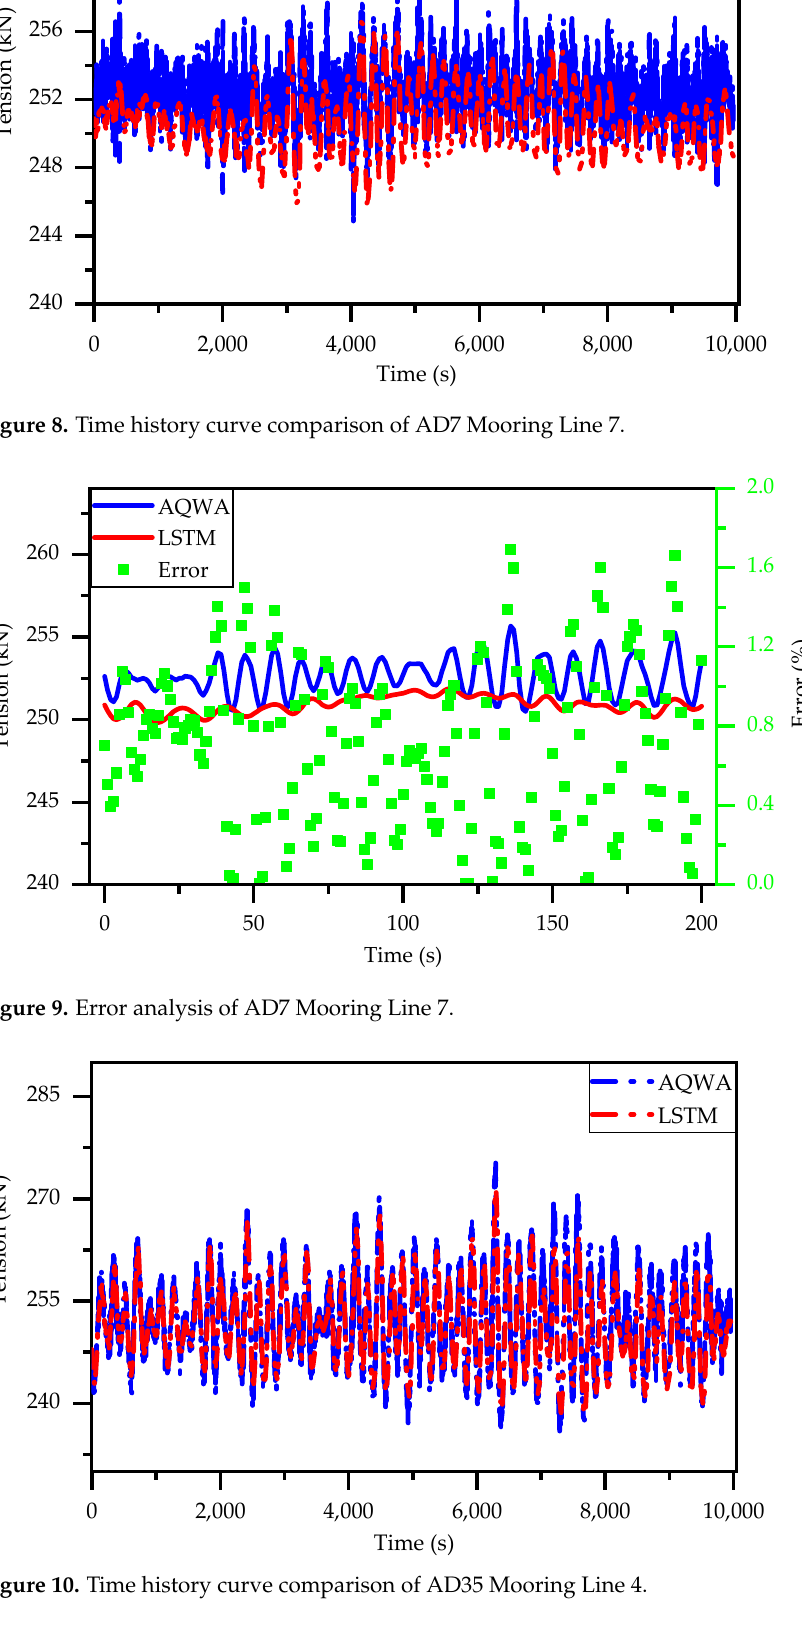
Figure 10. Time history curve comparison of AD35 Mooring Line 4.